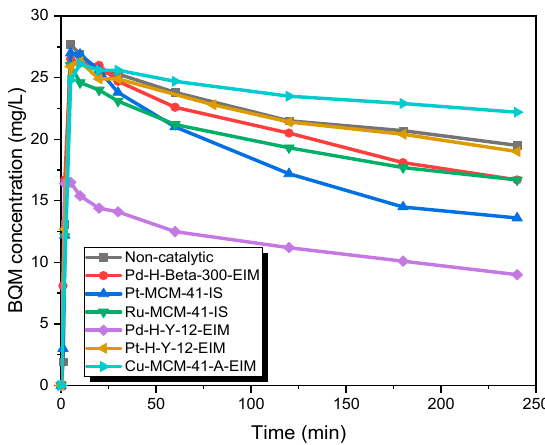
Figure 10. BQM concentration during the catalytic and non-catalytic ozonation of CBZ. C CBZ = 35 mg/L, gas flow rate = 110 mL/min, T = 50 °C, stirring speed = 900 rpm, C O3,g = 21 mg/L, C catalysts = 0.5 g/L.